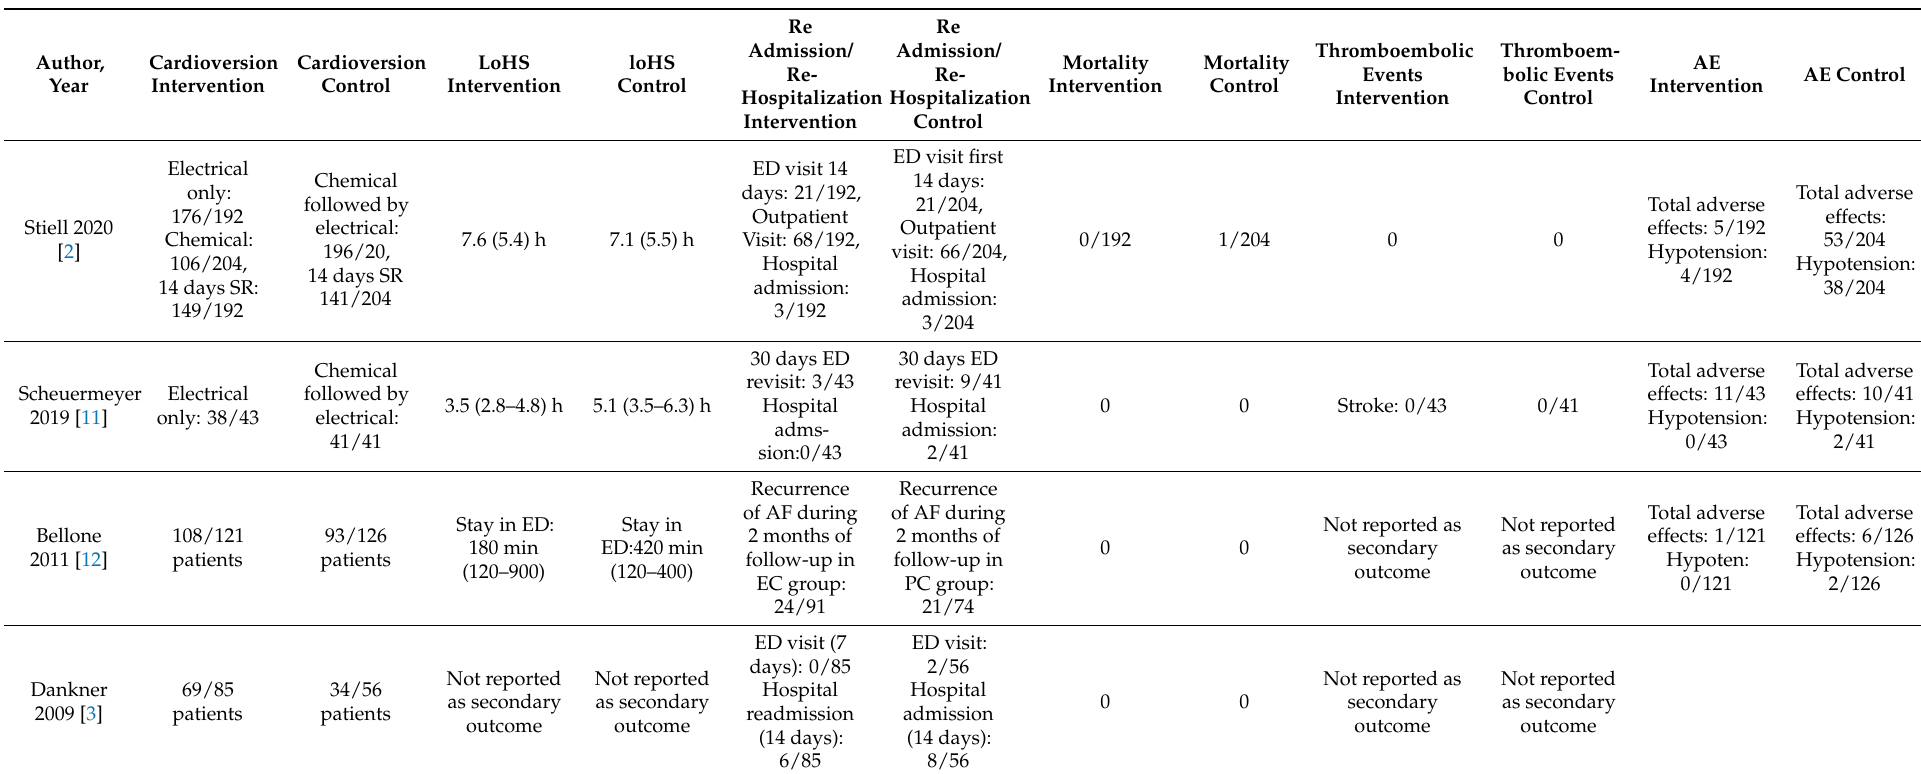
Table 3. Outcomes of included